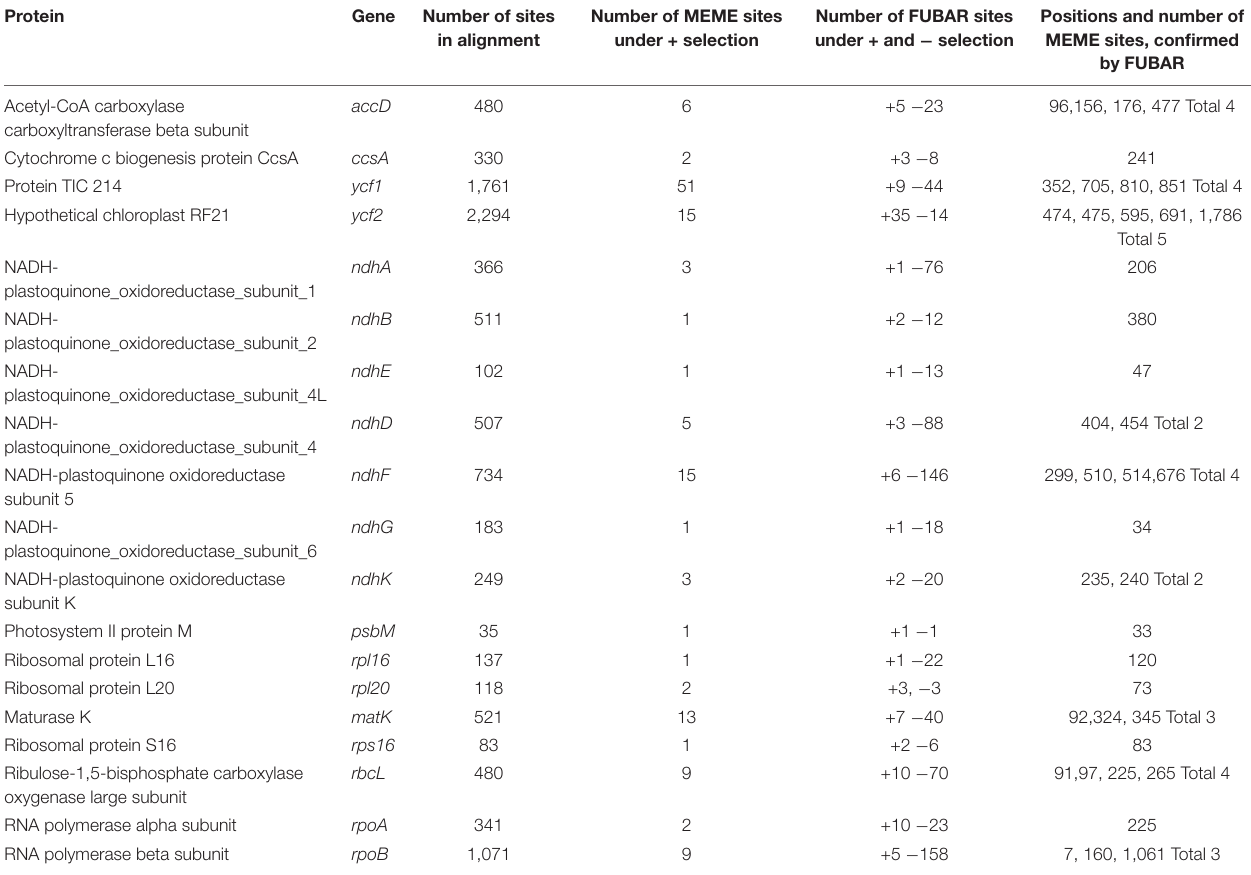
TABLE 1 | Sites under positive of diversifying selection in protein coding genes. Protein Gene Number of sites